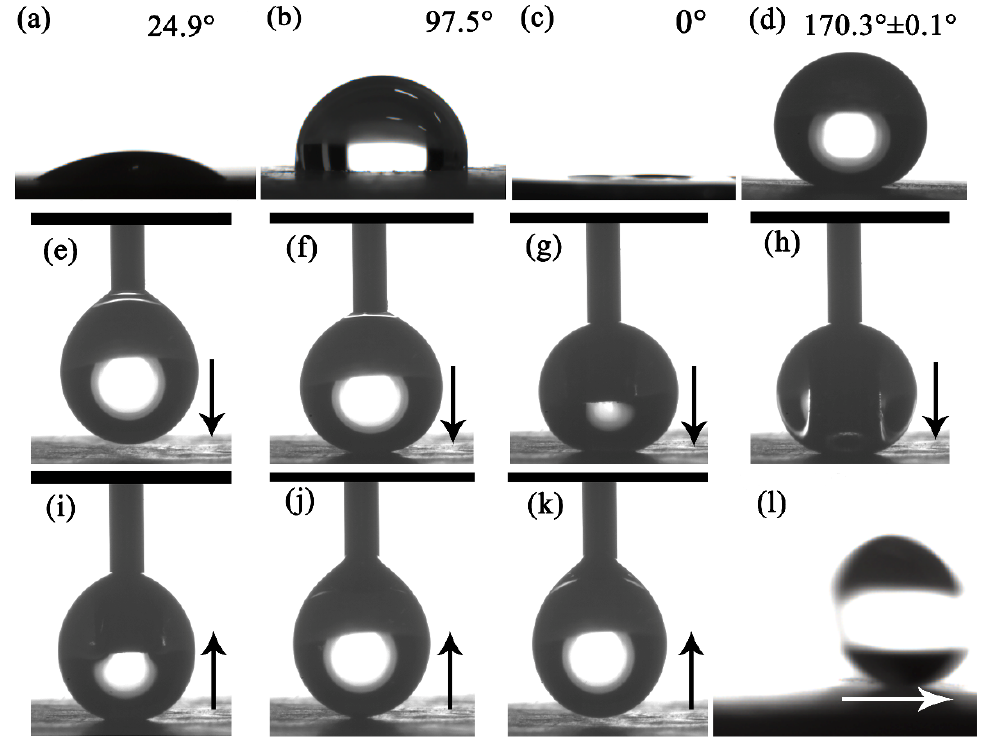
Figure 7. Optical images of the WCA on glass-ceramic surfaces: ( a ) original glass-ceramic surface; ( b ) 1H, 1H, 2H, 2H-perfluorodecyltriethoxysilane (FAS-17)-grafted original glass-ceramic surface; ( c ) hydrofluoric acid (HF)-etched glass-ceramic surface; and ( d ) HF-etched and FAS-17-grafted glass-ceramic surface; ( e – k ) process of water droplet approach, contact, deformation, and detachment for HF-etched and FAS-17-grafted glass-ceramic surfaces. The arrow represents the direction of movement of the needle; ( l ) a water droplet sliding on the surface.